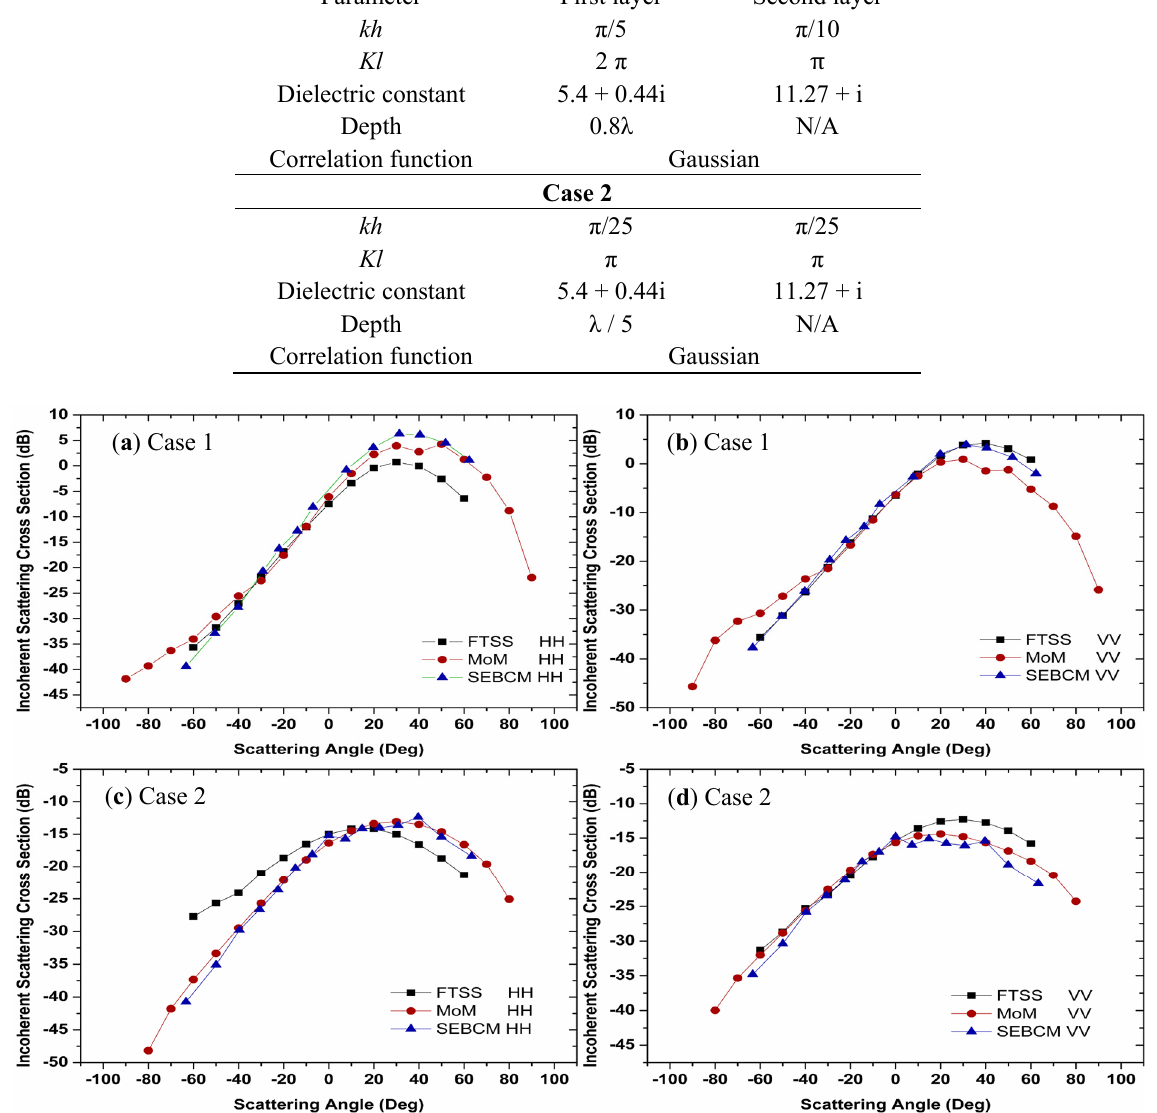
Figure 4. Comparison of incoherent scattering cross sections derived from FTSS, SEBCM, and MoM at 40° incident angle for a two-layer medium using model parameters summarized in Table 2 as Case 1 ( a , b ) and Case 2 ( c , d